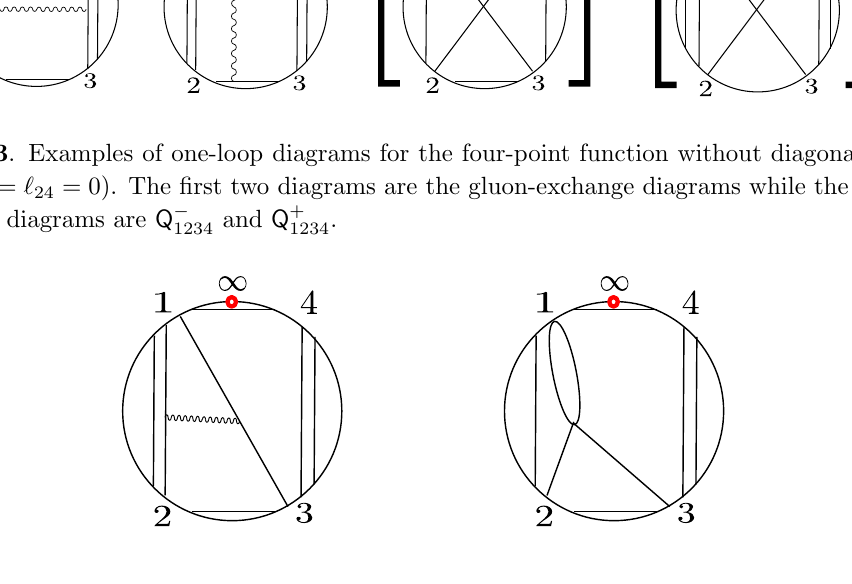
Figure 14 . Examples of one-loop diagrams for the four-point function with diagonal contractions ‘ 13 6 = 0. All the diagrams are basically the same as the one for the three-point diagrams. Namely they can be expressed as the sum of corner